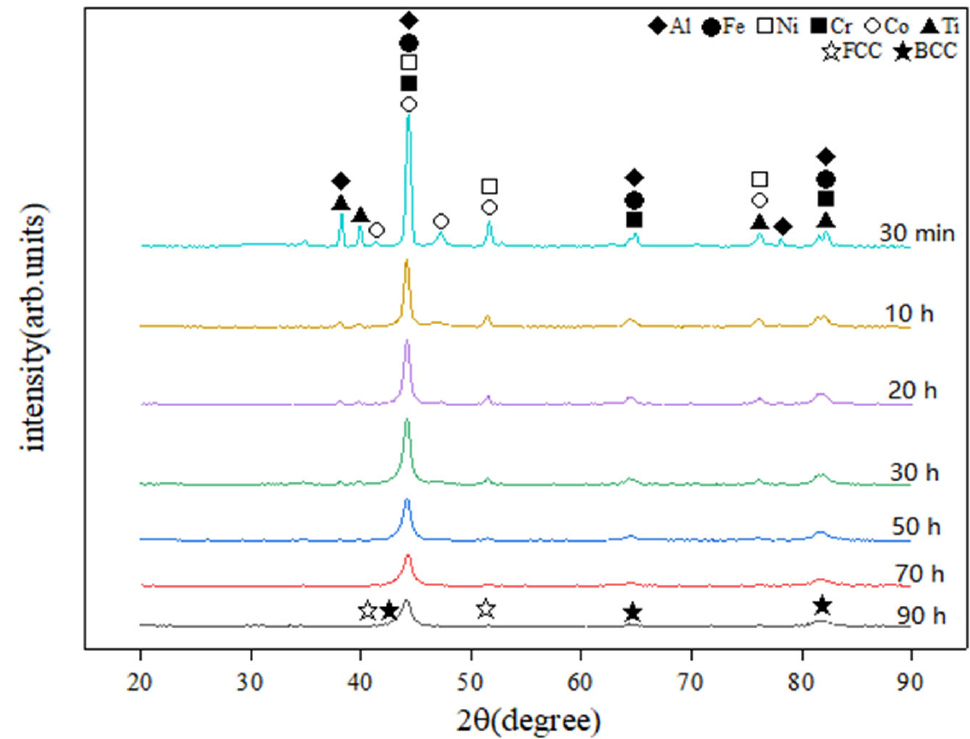
Figure 2. XRD pattern of high ‐ entropy alloy with different ball milling times.